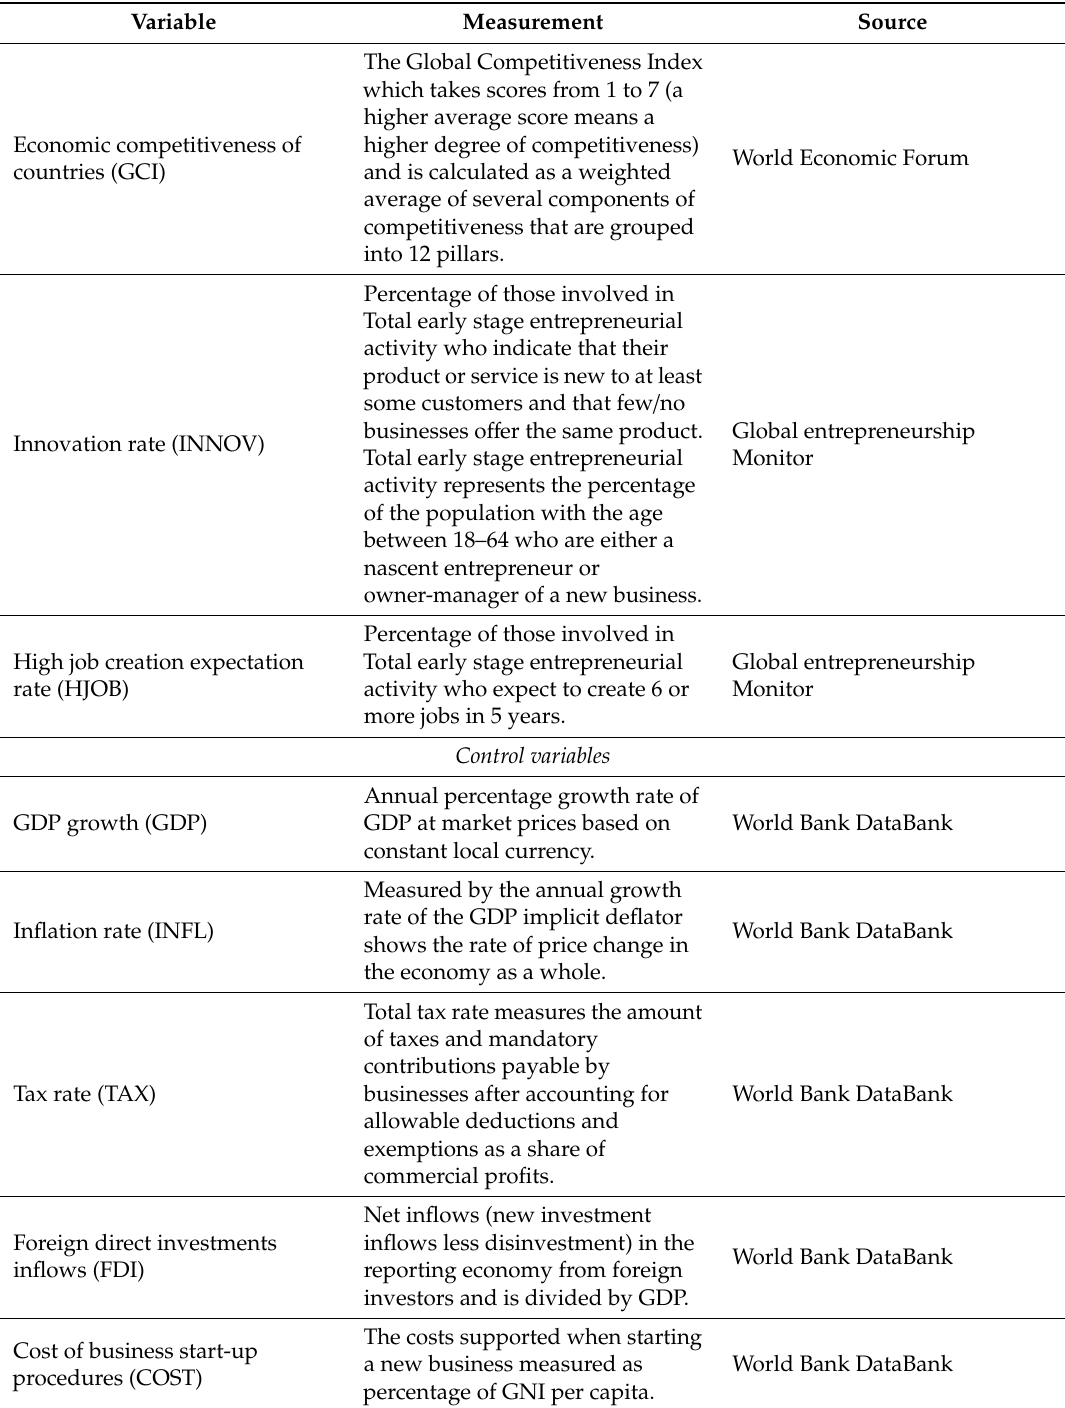
Table 2. The variables of the model, their measurement and